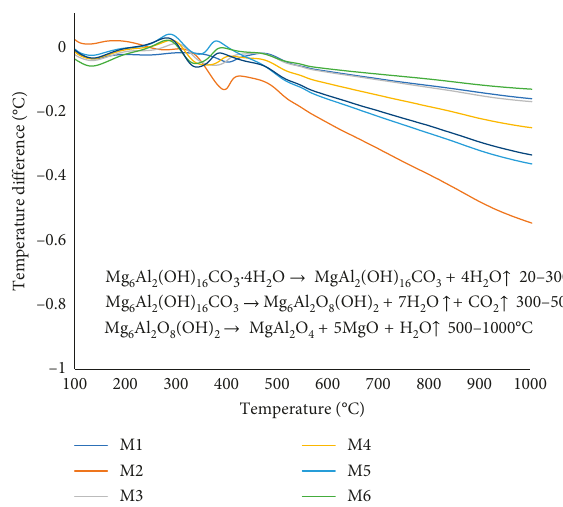
Figure 2: Differential thermal analysis of Mg/Al hydrotalcites with different Mg/Al ratios.